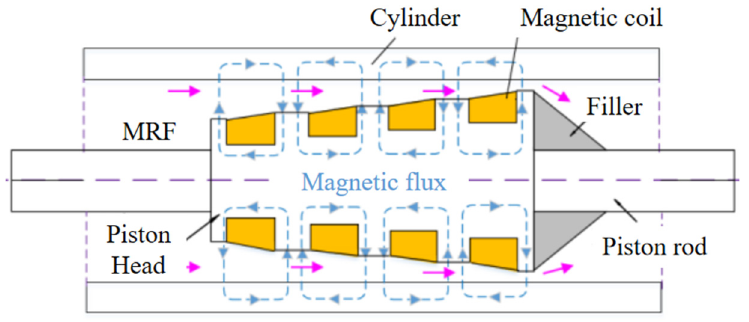
Figure 10. MRD with variable resistance gap